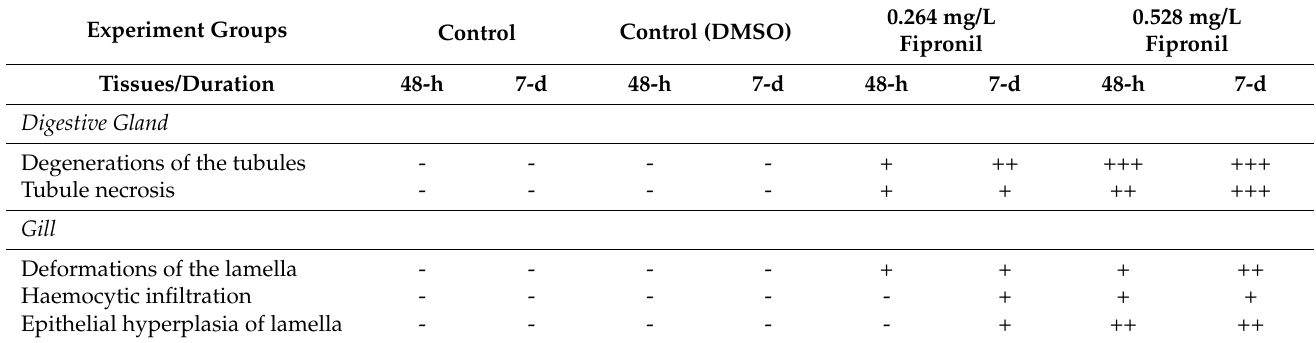
Table 2. Histopathological alterations of the freshwater mussel ( Unio delicatus ) exposure to sublethal fipronil concentrations.